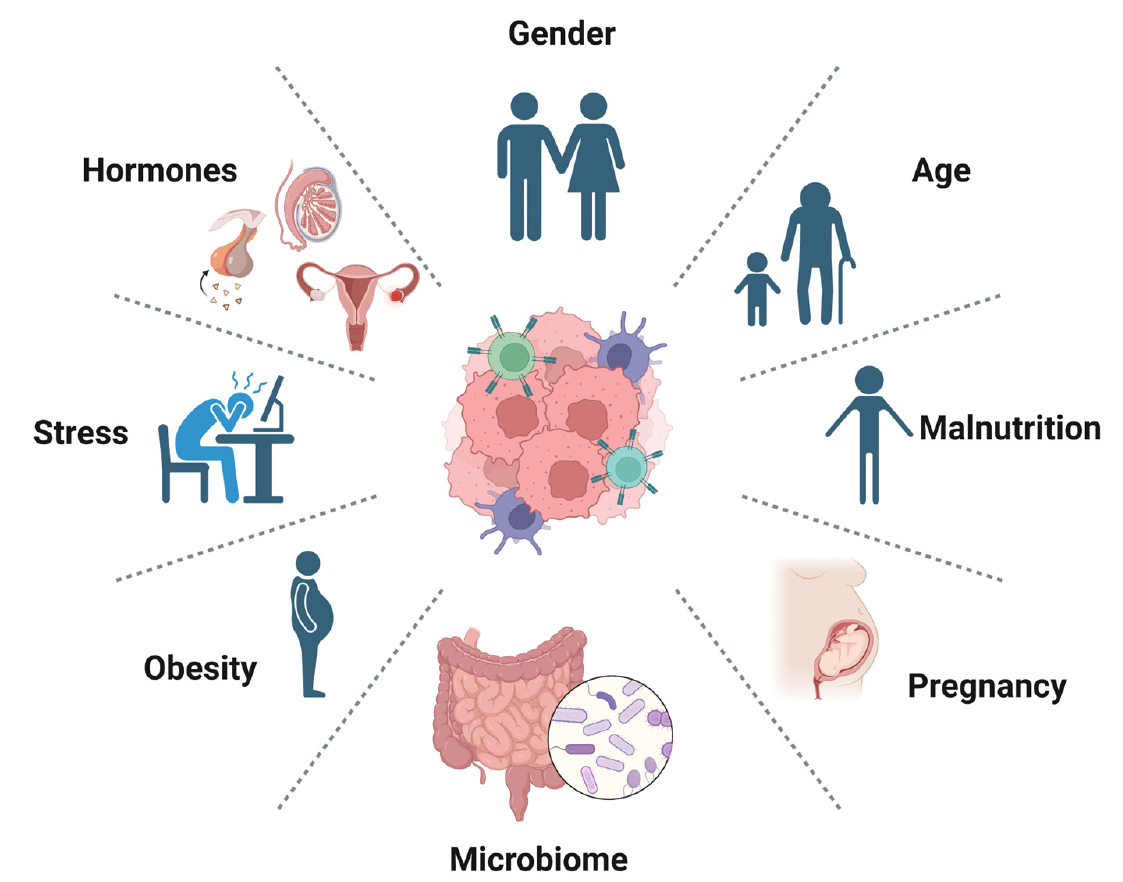
Figure 5. Host factors associated with resistance to immunotherapy in cancer patients. (I) Gender is a factor due to the physiological di ff erences between the innate and adaptive immune systems. (II) Age is indicated in studies as the elderly are more likely to develop resistance than their younger counterparts. (III) Malnutrition may interfere with cell-mediated immune responses, which may allow individuals to develop resistance to immunotherapy. (IV) Pregnancy-associated physiological adjustments, including immunotolerance, could interfere with immune recognition and, subse- quently, lead to resistance. (V) Microbiomes, such as Bi fi dobacterium , A. muciniphila , Faecalibacte- rium, and Bacteroidales, were associated with the enhancement of the immune response in cancer patients, while imbalances in the microbiota were abundant in cancer patients developing resistance to immunotherapy. (VI) Obesity was shown to increase resistance to immunotherapy using animal models of cancer. (VII) Stress is an environmental factor associated with the modulation of immune responses that weaken adaptive immune responses, leading to the failure of the response to immu- notherapy. (VIII) Hormones, such as testosterone, estrogen, and progesterone, also modulate the innate and adaptive immune responses, leading to variable responses to immunotherapy in both genders. Created with BioRender.com